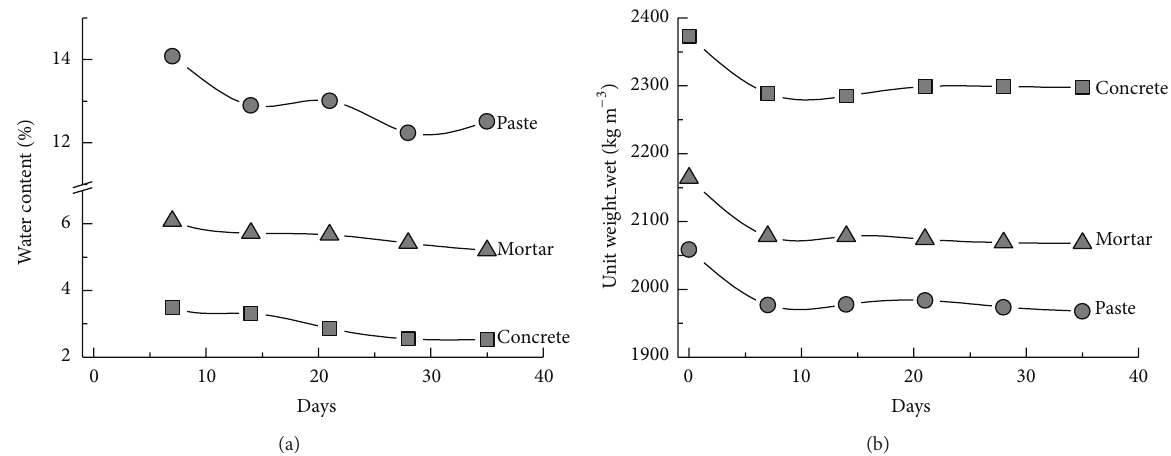
Figure 4: Changes in (a) water content and (b) wet unit weight of tested specimens during curing.